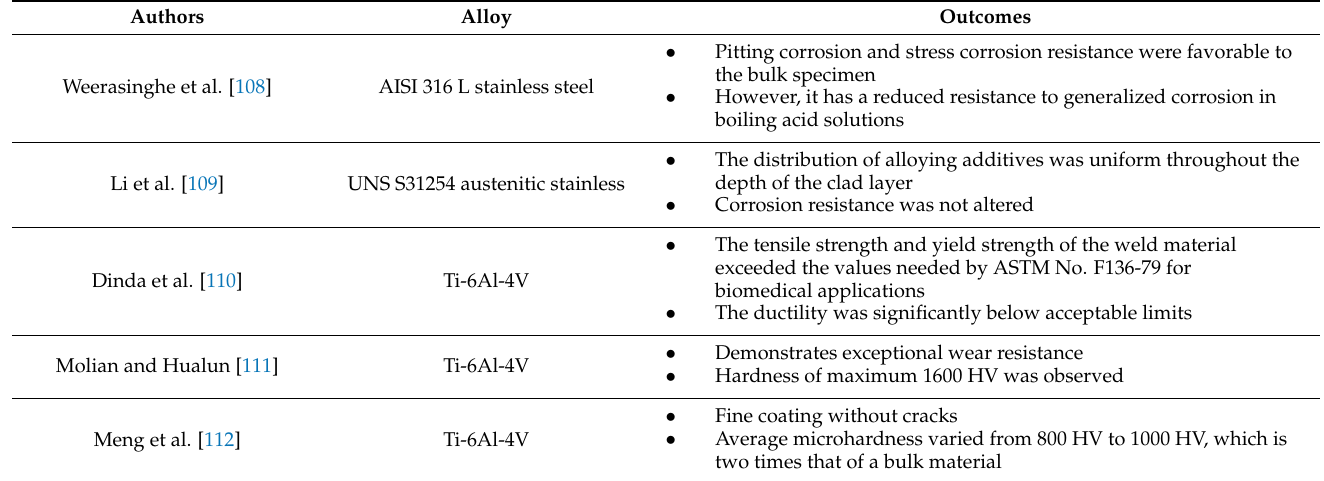
Table 7. LSC treatment on biomedical alloys.